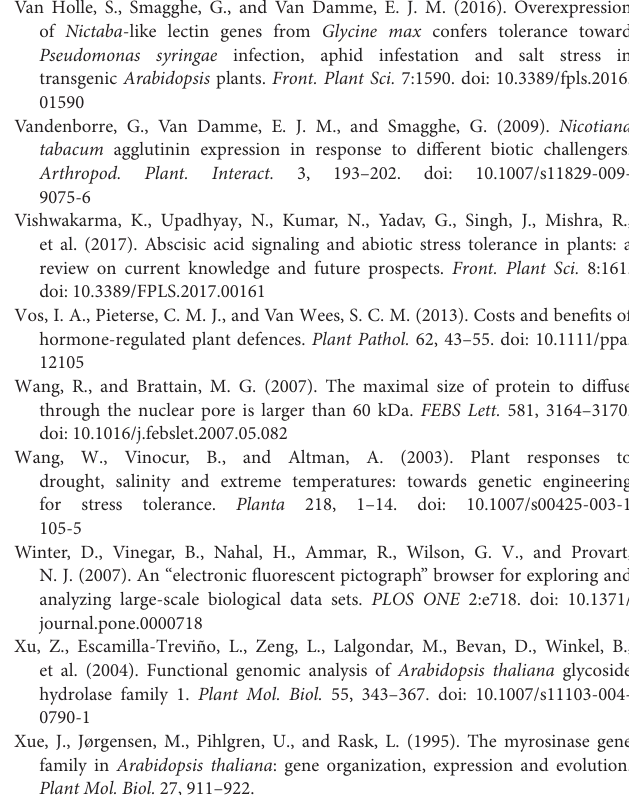
tabacum agglutinin expression in response to different biotic challengers. Arthropod. Plant. Interact. 3, 193–202. doi: